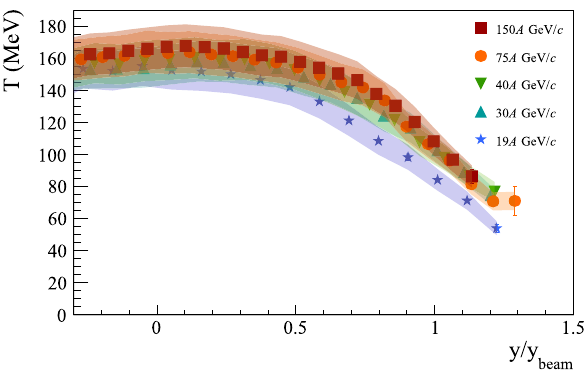
Fig. 12 The inverse slope parameter T of the transverse mass spectra of negatively charged pions in central Be + Be collisions at the SPS energies as a function of rapidity divided by the beam rapidity. The fit range is 0 . 2 < m T − m π < 0 . 7 GeV. Statistical uncertainties are mostly smaller than marker size, systematic uncertainties are indicated by shaded